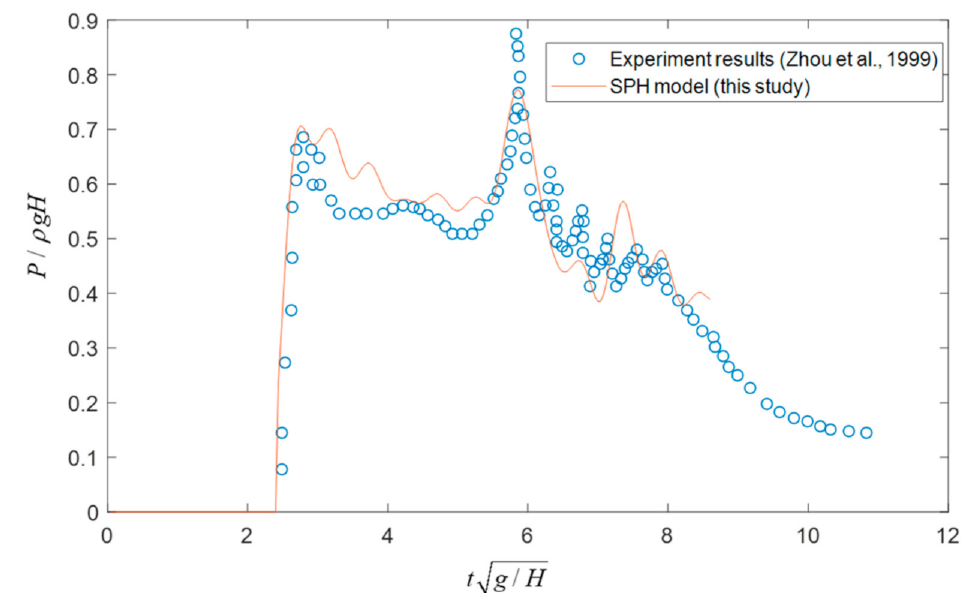
Figure 5. Time series of the pressure at point (3.22 m, 0.16 m) in Zhou et al.’s [55] numerical tank. The red solid line is the SPH simulation result of this study. The circles are experimental results from Zhou et al. [55].